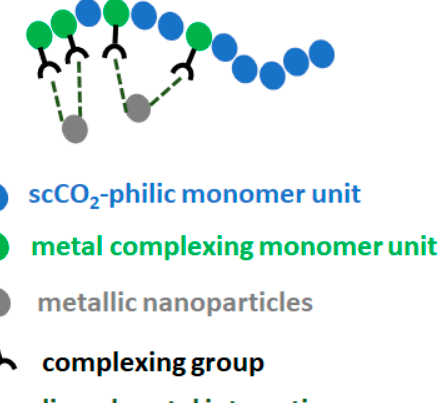
Figure 1. General design of scCO 2 -soluble polymers capable of complexing with Pd.